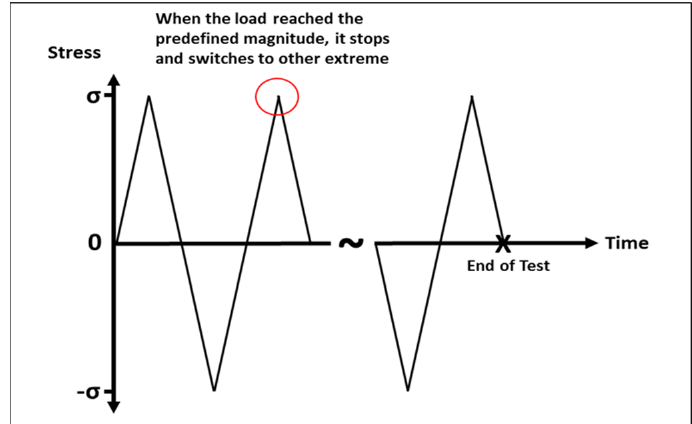
Figure 5. Mechanical fatigue testing profile.